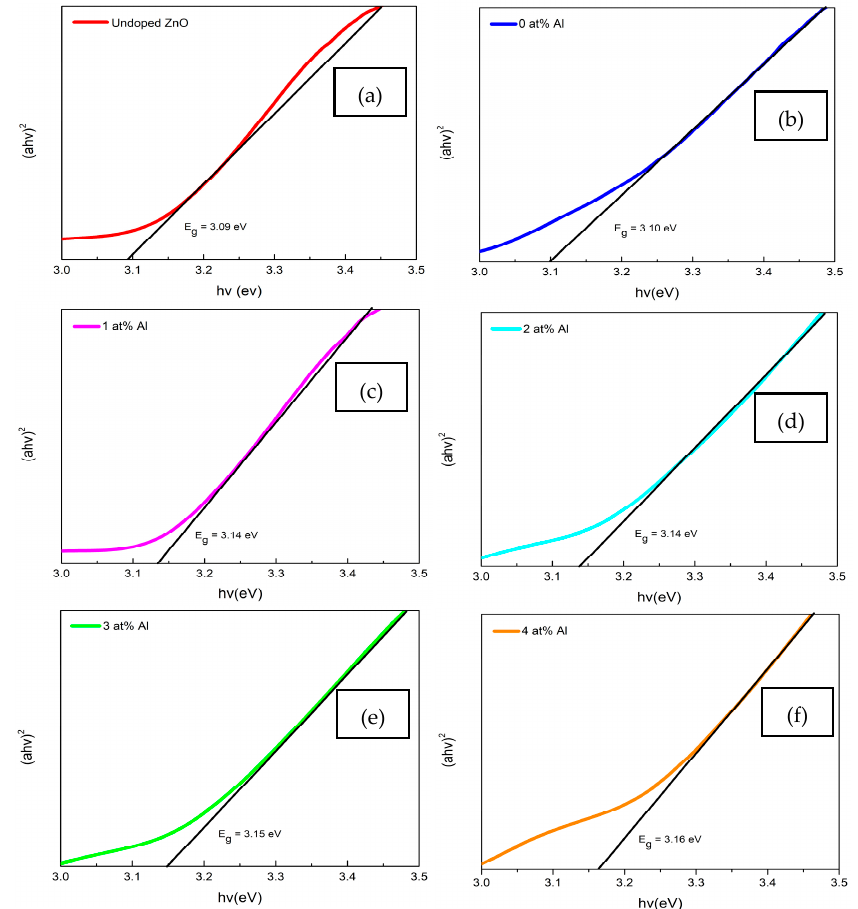
Figure 5. Extrapolation linear plot of band gap energy from Tauc’s plot equation of ( a ) Undoped ZnO, and (Gd, Al) co-doped ZnO films at different Al concentrations of ( b ) 0 at% Al, ( c ) 1 at% Al, ( d ) 2 at% Al, ( e ) 3 at% Al, and ( f ) 4 at% Al.